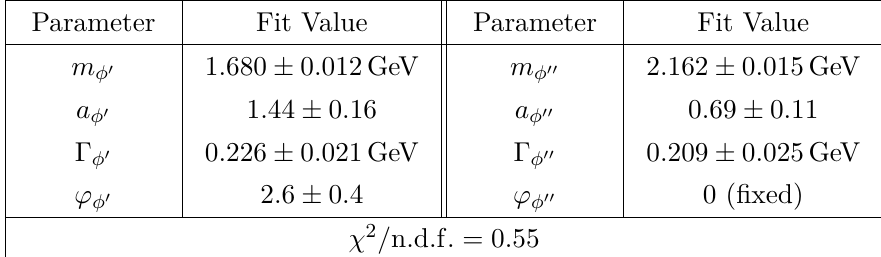
Table 6 . Values obtained by the fit for the e + e − → φππ current.